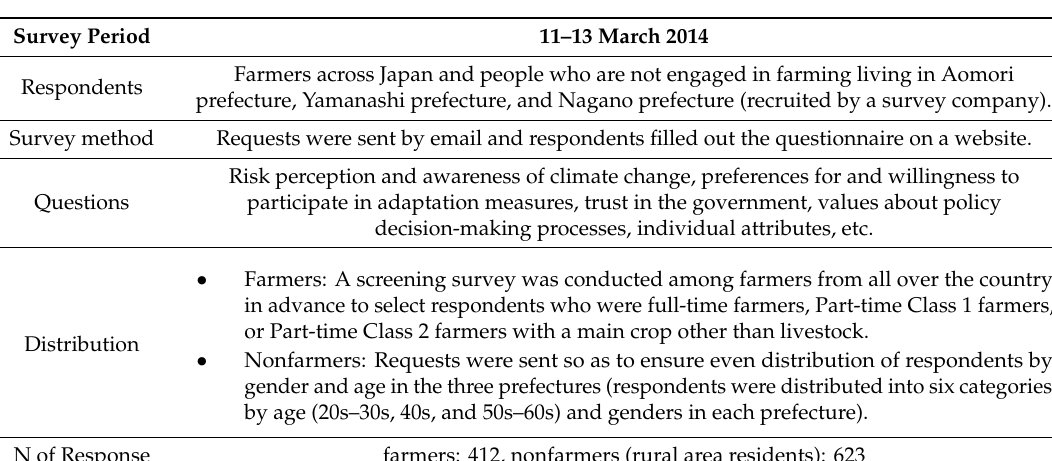
Table 1. Overview of